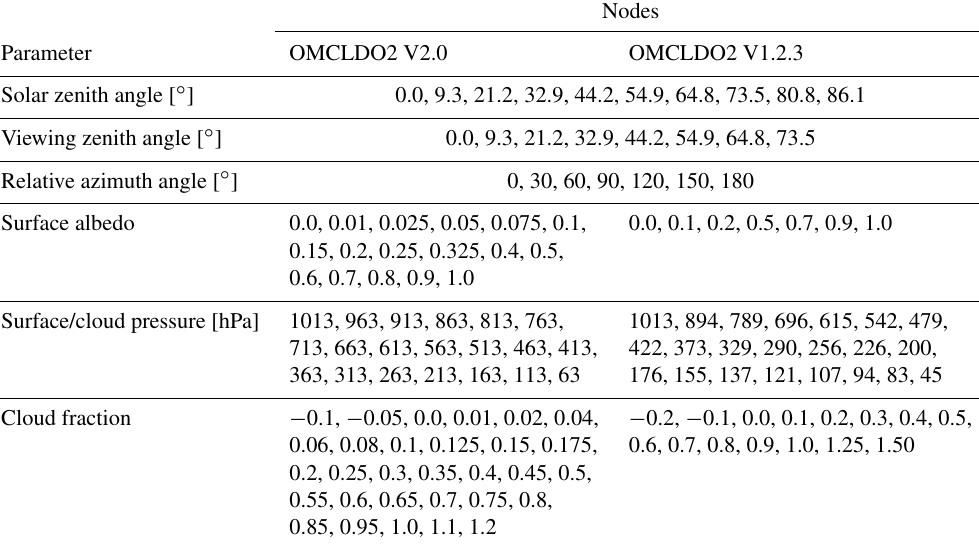
Table 1. Nodes for the radiative transfer calculations used for the OMCLDO2 algorithm v2.0 and v1.2.3. Where the nodes are the same between versions, the table cells are merged. Note that cloud fractions smaller than 0 and larger than 1 are included to enlarge the parameters space.